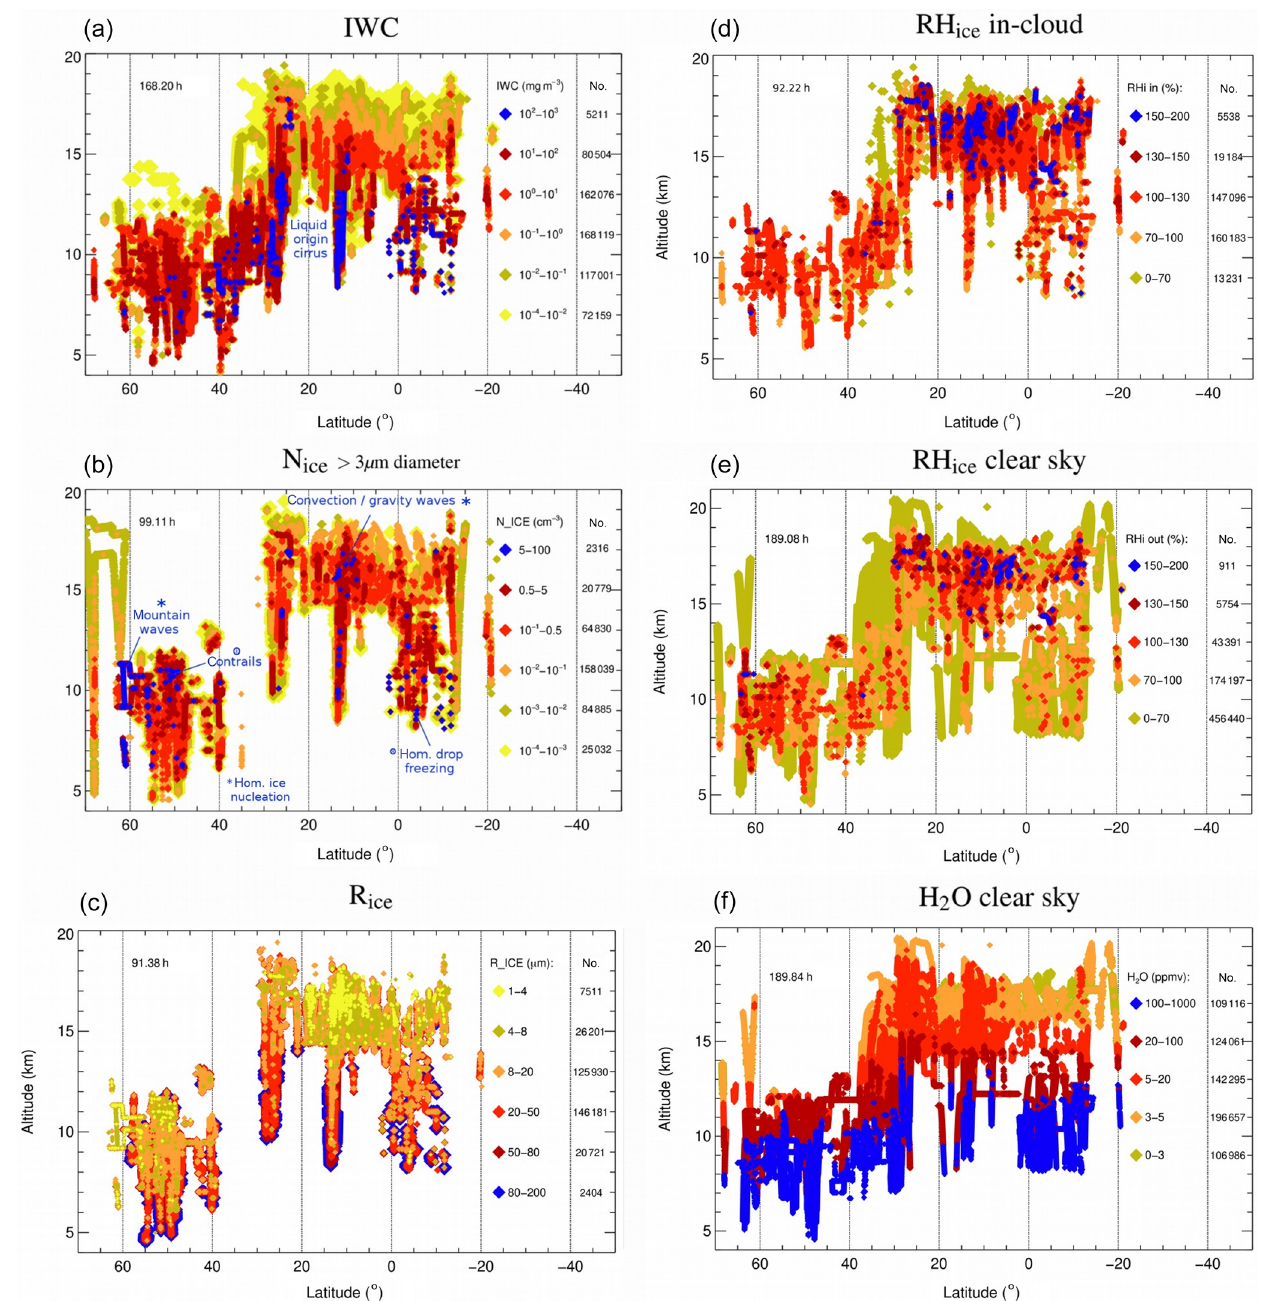
Figure 3. Cirrus cloud distribution with latitude and altitude of (left column, panels a–c ) ice water content (IWC, a ), ice crystal number ( N ice , size > 3µm diameter, b ), and mean mass radius ( R ice , calculated from IWC /N ice , c ). (Right column, panels d–f ) In-cloud and clear- sky relative humidity with respect to ice (RH ice , d , e ) and clear-sky water vapor volume mixing ratio (H 2 O, f ). The field campaigns are listed in Table A1, and data evaluation methods and detection ranges of the parameters are described in Appendix A. The color codes range from yellow to blue with increasing amount of the respective parameter; for R ice , the color code is reversed to indicate that high and low N ice values belong to small and large R ice ; note that the data points are plotted in the order of the colors from yellow to blue; frequencies of occurrence of the parameters can be seen in Fig.